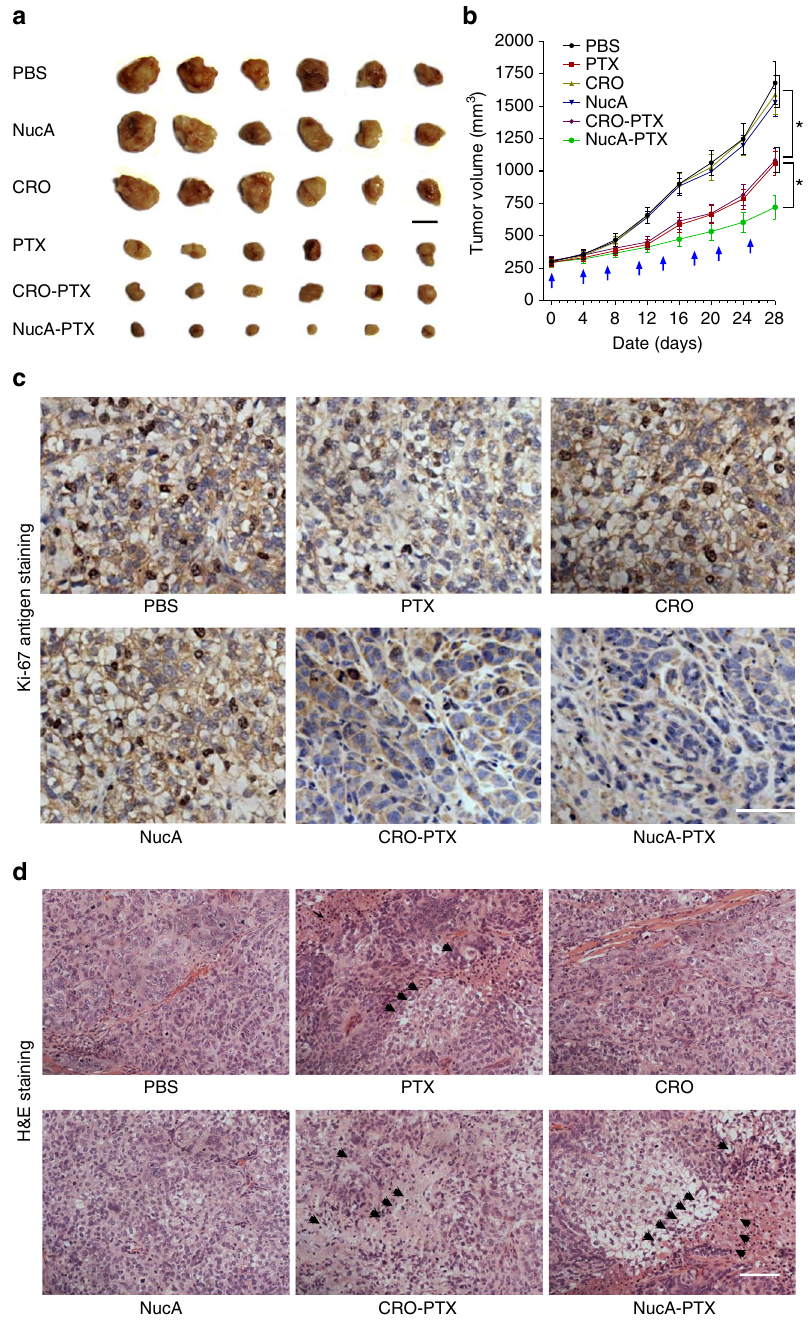
Fig. 7 The effect of NucA modi fi cation on the antitumor activity of the conjugated PTX. a Macroscopic views of the xenografted tumor after 4 weeks of different treatments from the groups indicated. Scale bar, 1 cm. b Analysis of tumor volume after 4 weeks of different treatments indicated at a dosing frequency of twice a week via intravenous injection. The dosing points were indicated with blue arrows. The data were presented as the means ± standard deviation. n = 6, * P < 0.05. c Ki-67 immunohistochemical staining analysis of ovarian tumor sections from the groups indicated. Ki-67-positive staining was indicated by brown and nuclei were stained by blue. Scale bars, 100 μ m. d H&E staining analysis of ovarian tumor sections from each group. Arrows indicate cell apoptosis and necrosis in the tumor sections. Scale bars, 100 μ m. Note: PBS, the xenografted mice treated with PBS. PTX, the xenografted mice treated with paclitaxel. CRO, the xenografted mice treated with CRO aptamer. NucA, the xenografted mice treated with nucleolin aptamer. CRO-PTX, the xenografted mice treated with CRO-PTX. NucA-PTX, the xenografted mice treated with